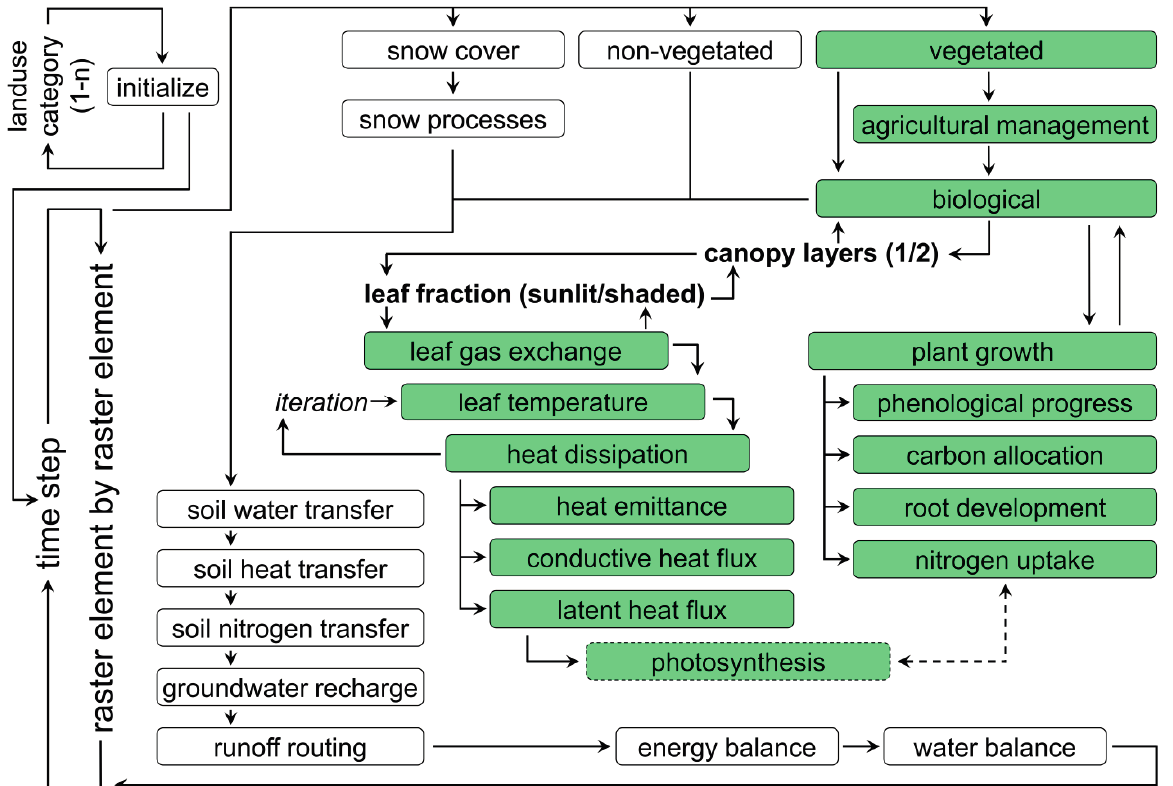
Figure 1. Internal design of the enhanced PROMET agroecological land surface model. The extended model components relevant for this study are highlighted in